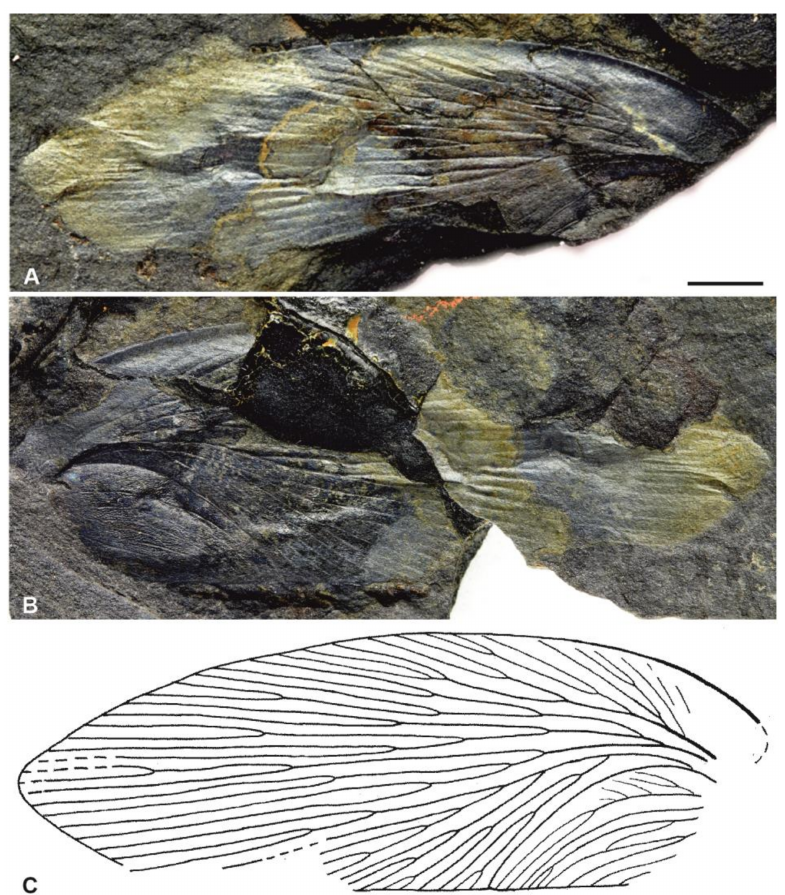
Figure 8. ( A – C )— Progonoblattina clarkii (Scudder, 1893): type specimen of ‘ Phoberoblatta grandis ’ Handlirsch, 1906a; Fishing Creek Gap; USNM PAL38756, ( A , B )—part and counterpart; length 50 mm; scale bar 5 mm.